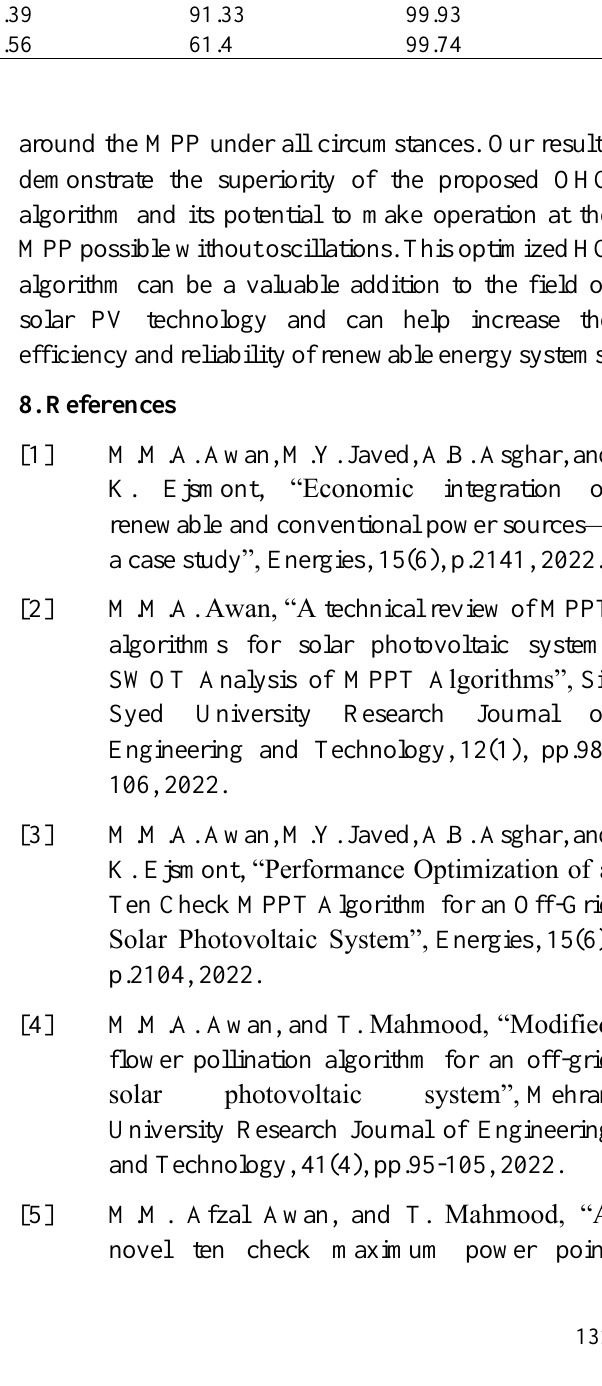
Table 3 Performance summary of the proposed optimized hill climbing algorithm